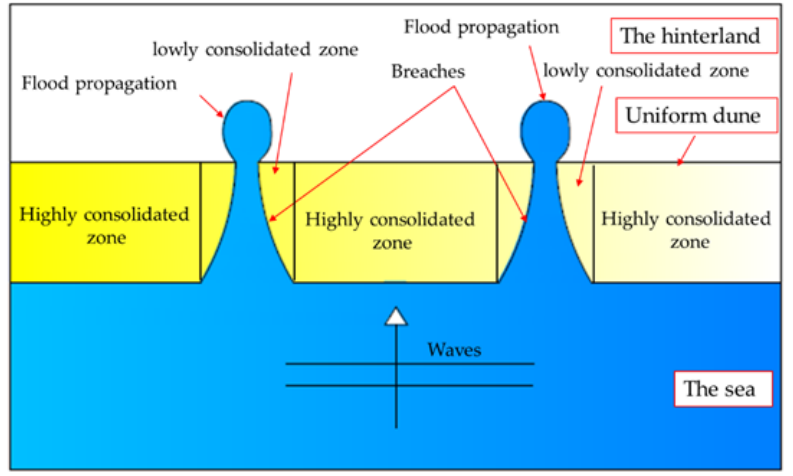
Figure 21 . Effect of longshore variability of dune resistance on barrier breach initiation (Schematic).